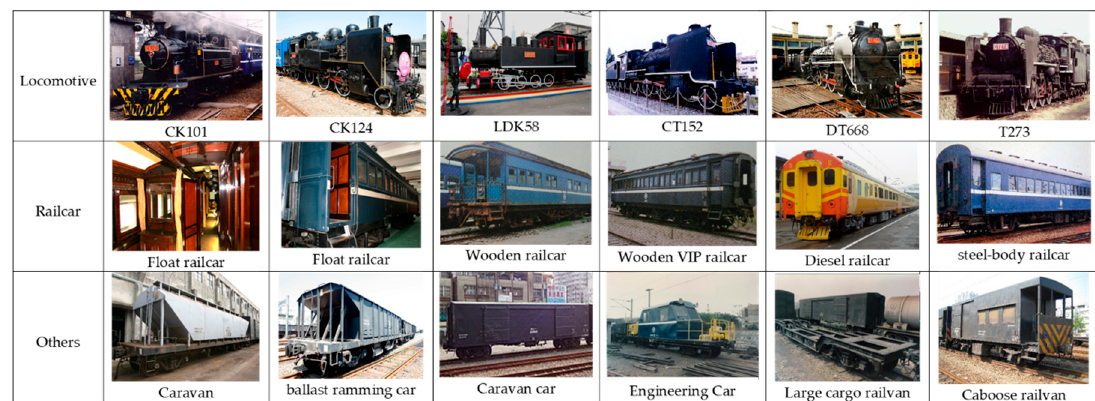
Figure 5. Some pictures of collecting trains for National Railway Museum in Taiwan (adapted from TWA).